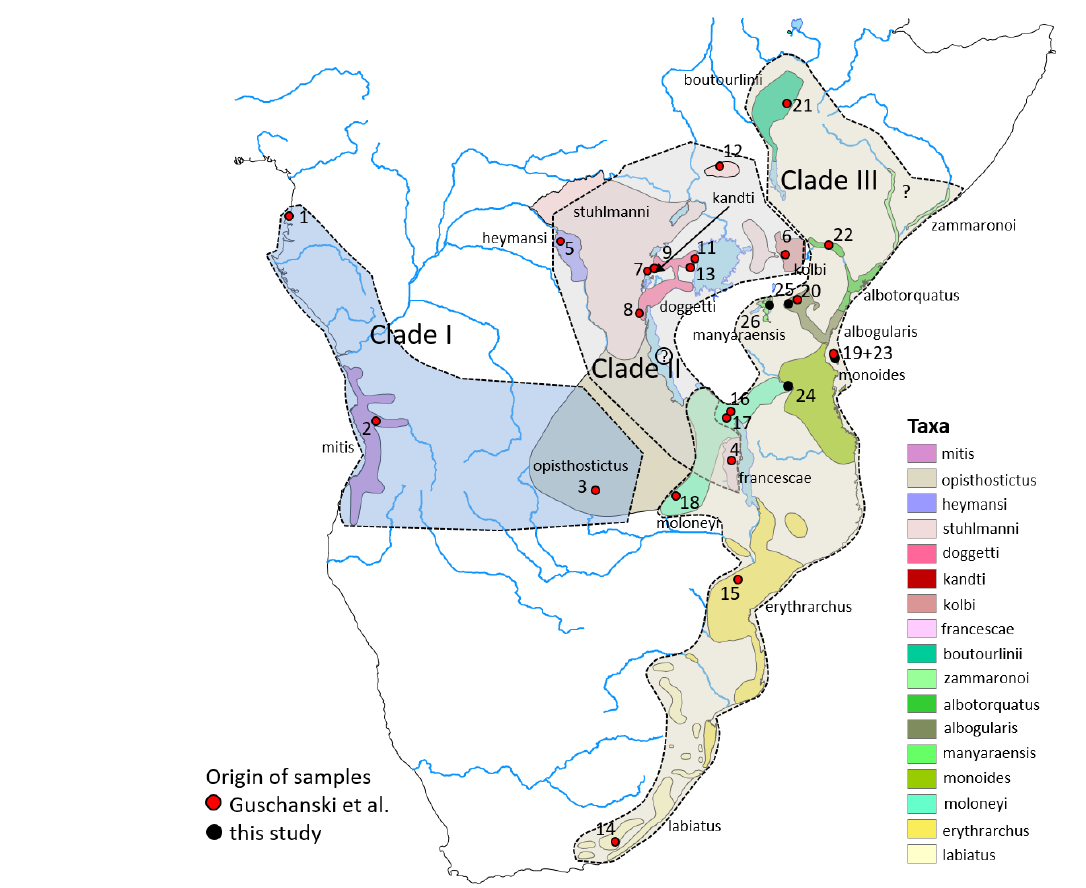
Figure 3. Distribution ranges of gentle monkey Cercopithecus mitis taxa and the approximate distribution ranges of the three major mito- chondrial clades I–III. Basemap by